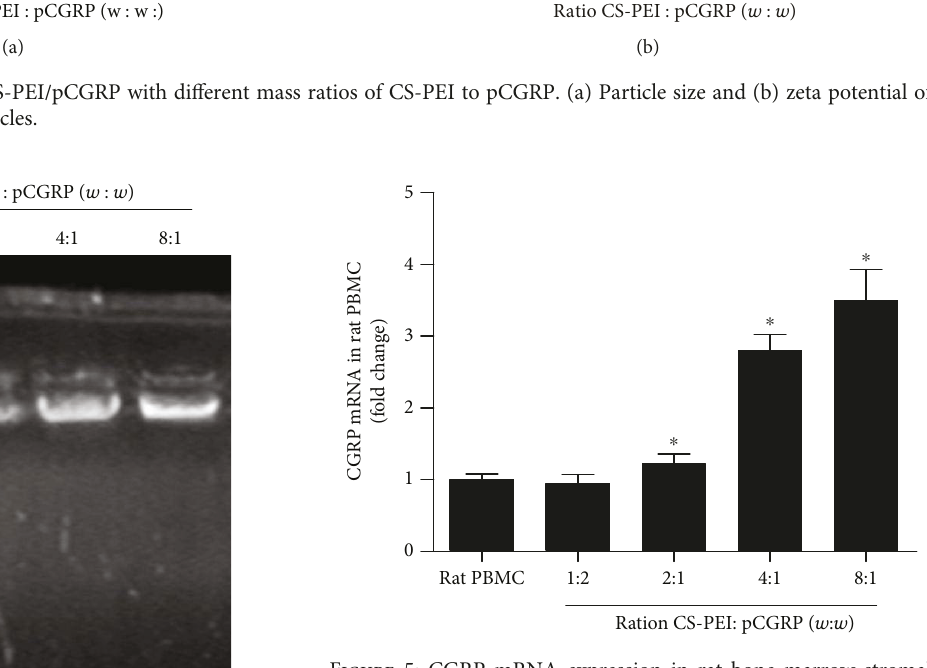
Figure 5: CGRP mRNA expression in rat bone marrow stromal cells (BMSCs) transfected with CS-PEI/pCGRP at di ff erent CS-PEI :pCGRP ratios ( w : w ). Data are mean ± standard deviation ( n = 3 ). ∗ P < 0 05 vs.